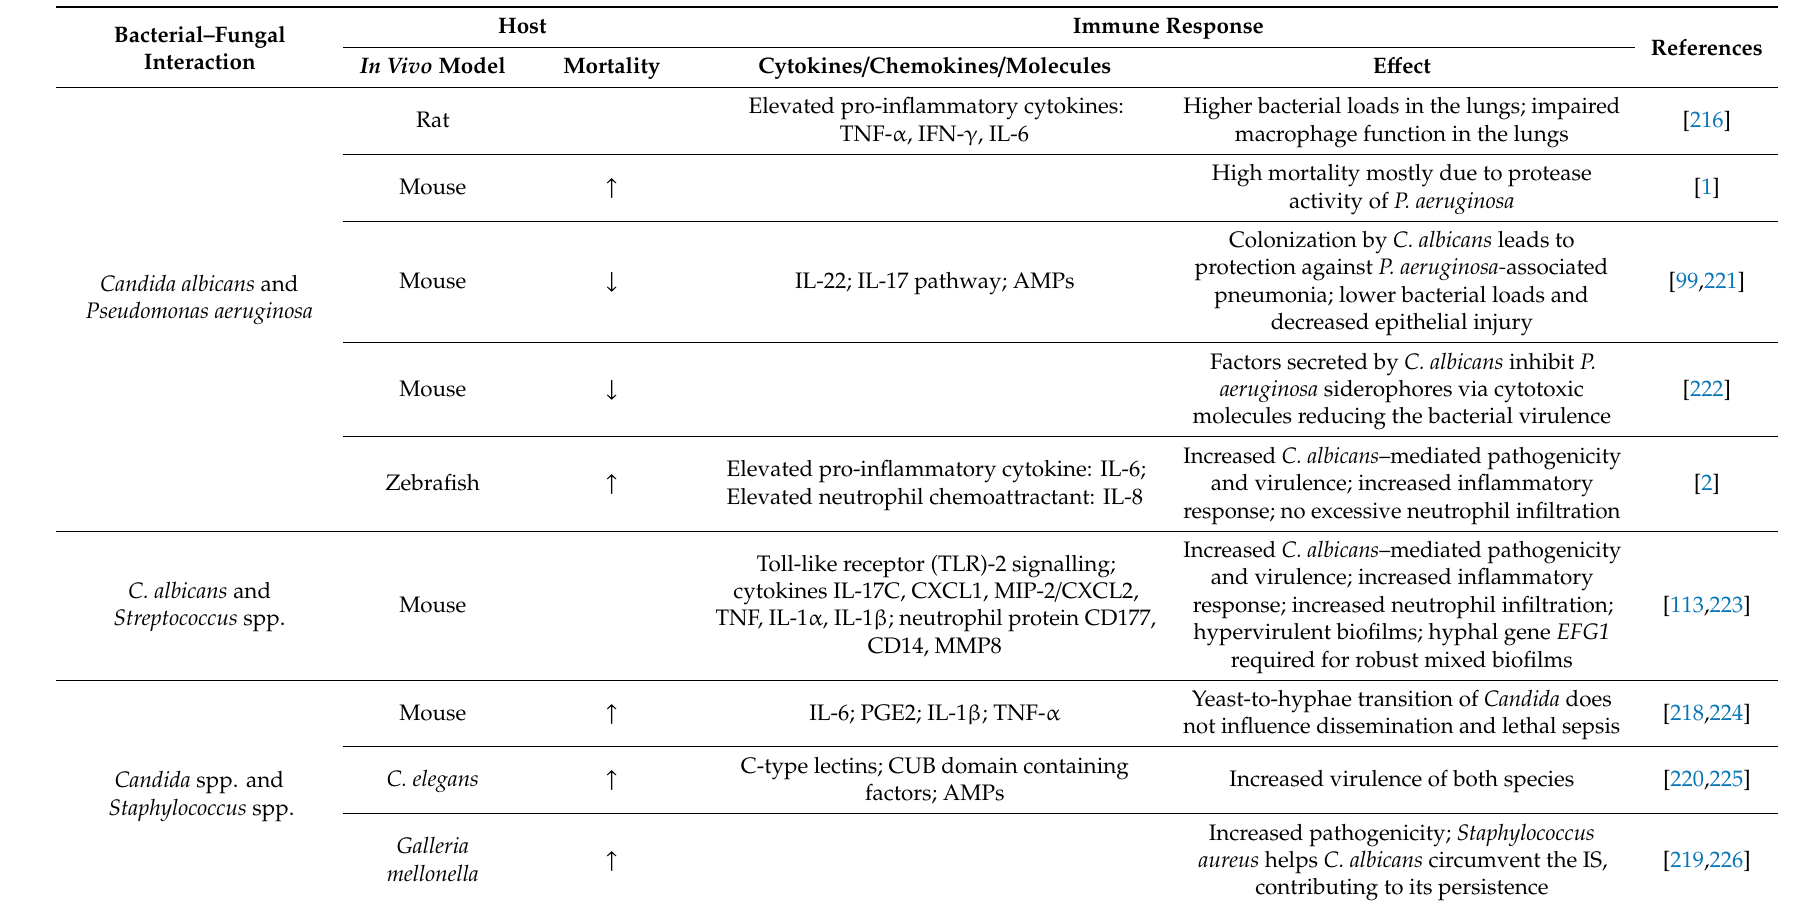
Table 1. Animal models used for studies of bacterial–fungal interactions and immune